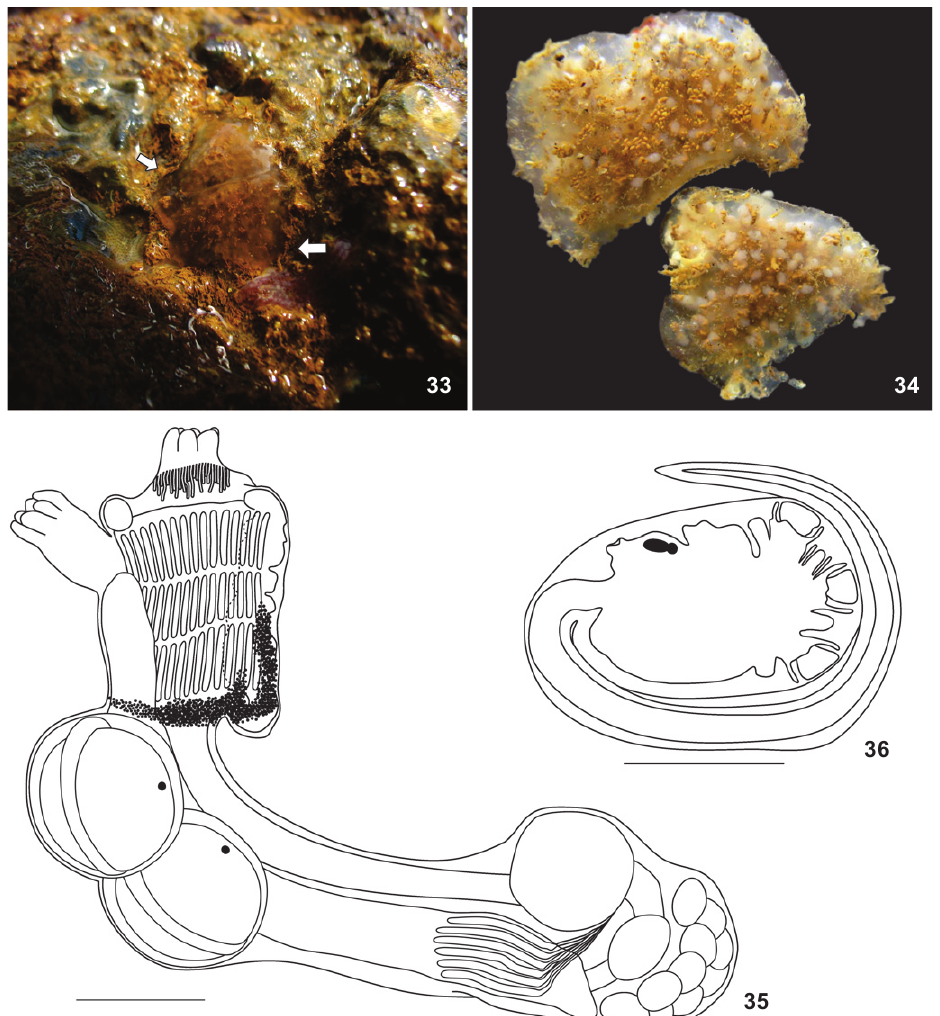
Figures 33-36. Eudistoma sp. 2: (33) colonies on the substrate (white arrows); (34) colonies in formalin; (35) zooid; (36) larva. Scale bars = 0.3